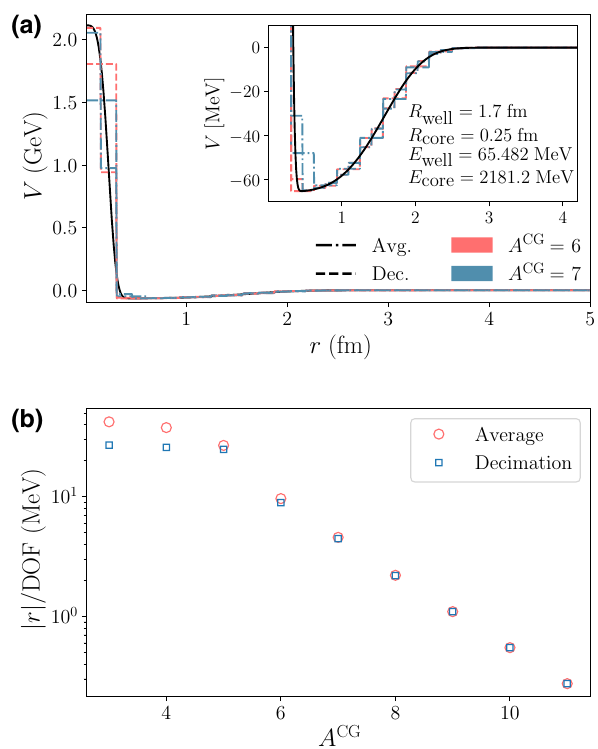
FIG. 5. (a) The S -wave potential Eq. (21), with parameters in the inset tuned to reproduce the deuteron binding energy (solid black line), and the respective discretized potentials on coarse- grained lattices. The inset graph enlarges into the bottom of the well near r = 0.5 fm to show how the discretization approxi- mates the potential there. (b) The L 1 -normed error per degree of freedom (DOF) of the coarse-grained potential as a function of the number of qubits used to represent the coarse-grained lattice. As A CG increases, the L 1 -normed difference from the continuum potential exponentially decreases. the potential given by, Eq. (21), the averaging can be performed